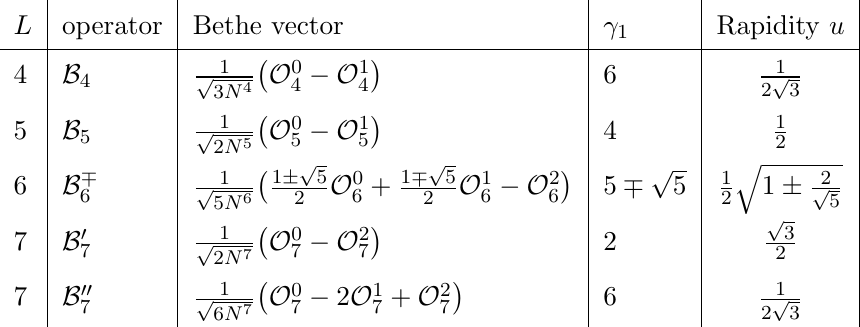
Table 1 . BMN operators with two impurities and length L (cid:20) 7. we also list the one-loop anomalous dimension (cid:13) 1 and the Bethe rapidity u = u 1 , cf. eq. (2.8). Operators are normalised so that their two-point function reads hB L B L i = 1 + O (1 =N 2